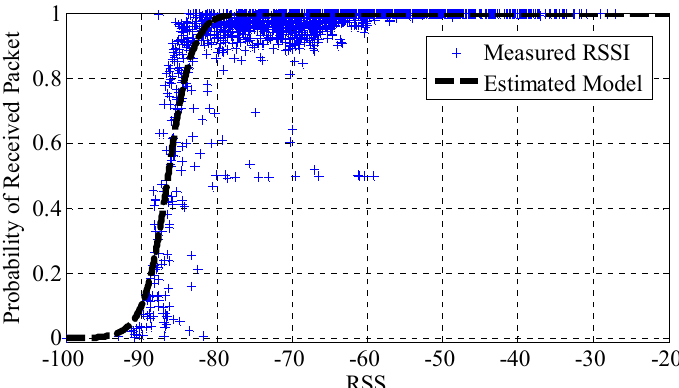
Figure 8. Probability of received packet (PRP) vs . received signal strength.